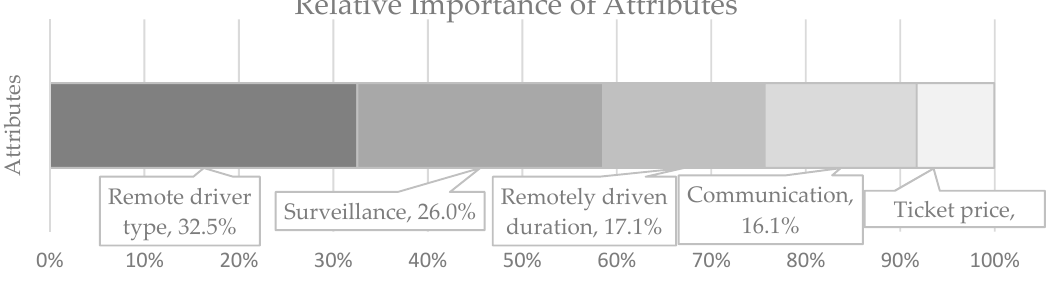
Figure 10. Relative importance of attributes.